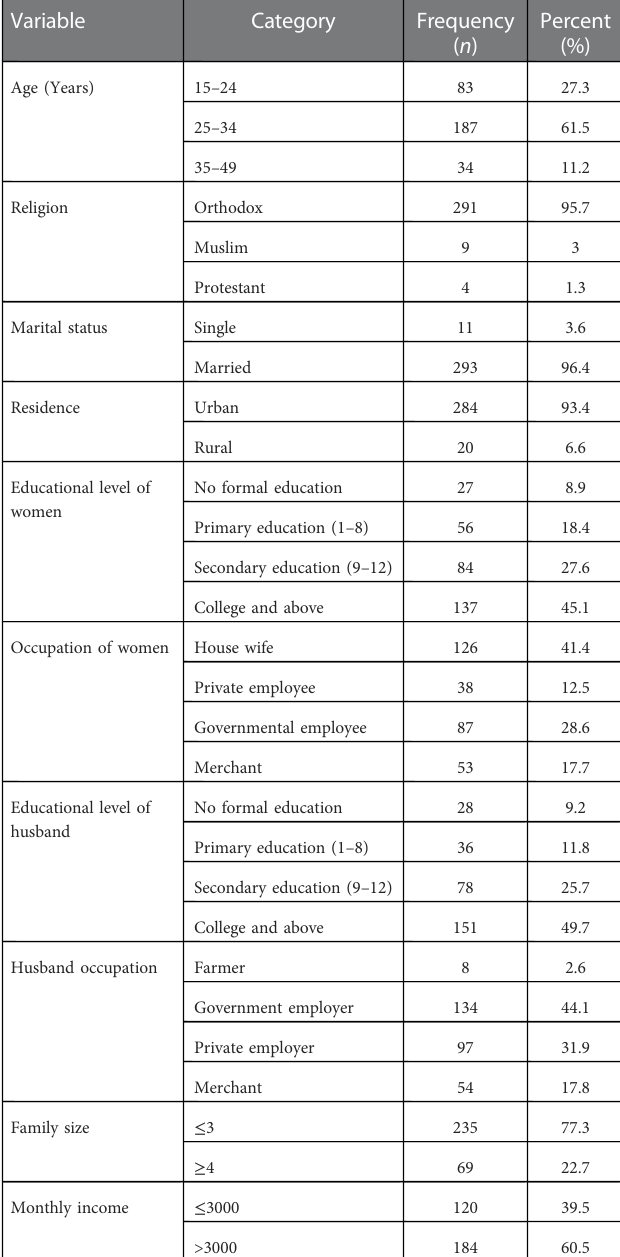
TABLE 1 socio-demographic characteristics of pregnant women attending ANC at Debre Markos in a public institution of Debre Markos, north-west, Ethiopia, 2021 ( n